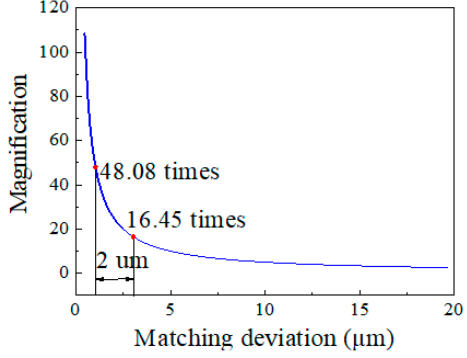
Figure 1. Relationship between M ‐ factor and OPL matching deviation.